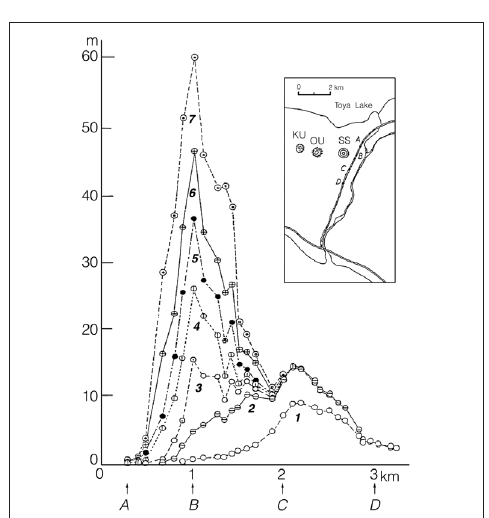
Fig. 6. Results of repeated precise levels at the east- ern base of the 1944 dome (SS) after Minakami (1947). The periods of the surveys 1 ∼ 7 are indicated in fig. 7.